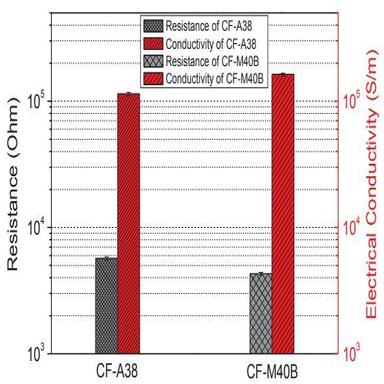
DC electrical resistance (R, grey bars) and conductivity (σ, red bars) of single CFs measured at a fiber length of 25.0 mm (error bars represent the corresponding standard deviations).